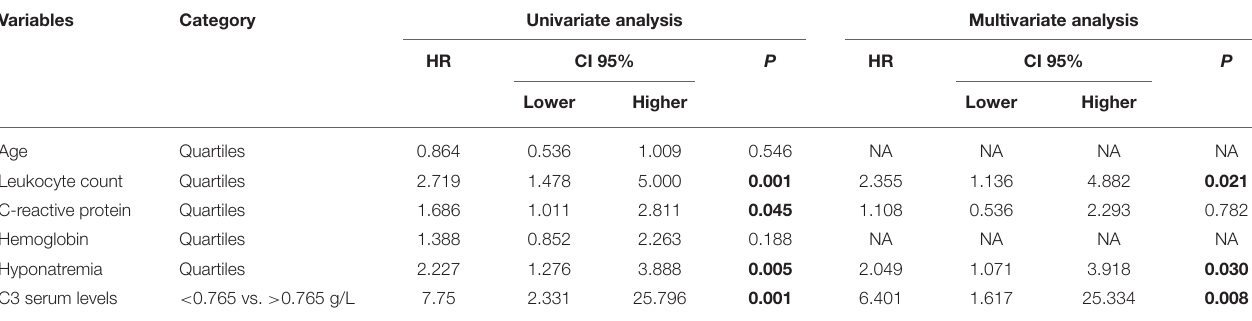
TABLE 3 | Univariate and multivariate binary logistic regression for central nervous system (CNS) involvement in STEC-HUS patients.